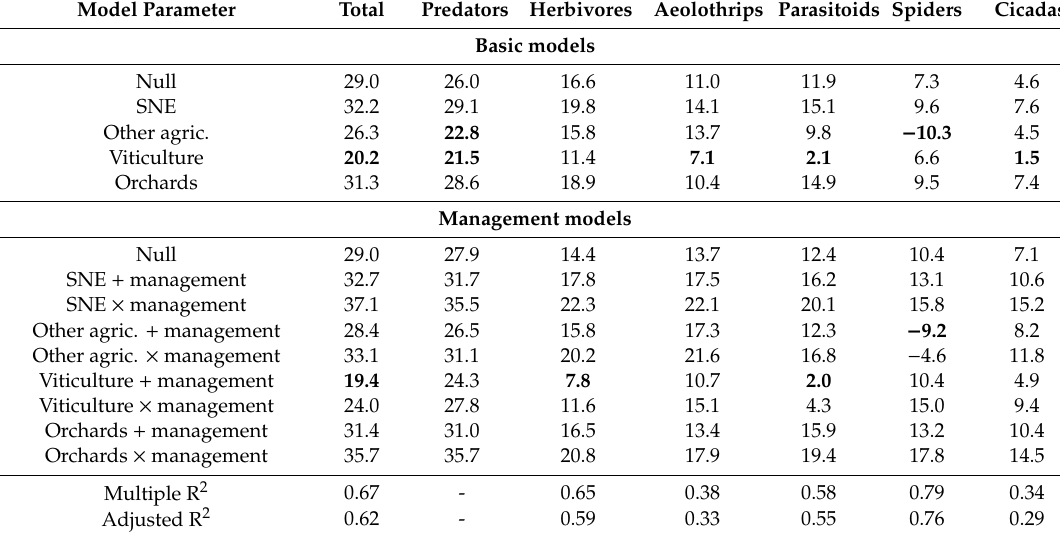
Table 3. Comparison of alternative models (using Akaike Information Criterion corrected for small sample sizes, AICc) for the main arthropods and groups found in Andalusian vineyards. The best model(s) is indicated in bold font. SNE = semi-natural